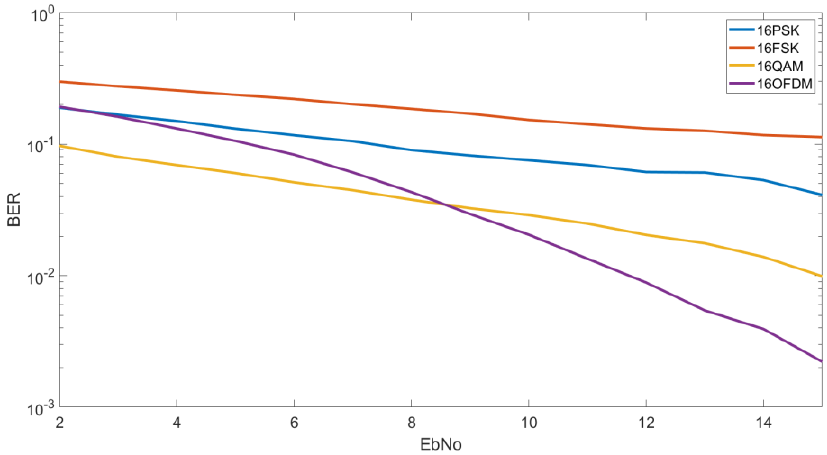
Figure 6. BER vs. E b /N 0 M = 8.